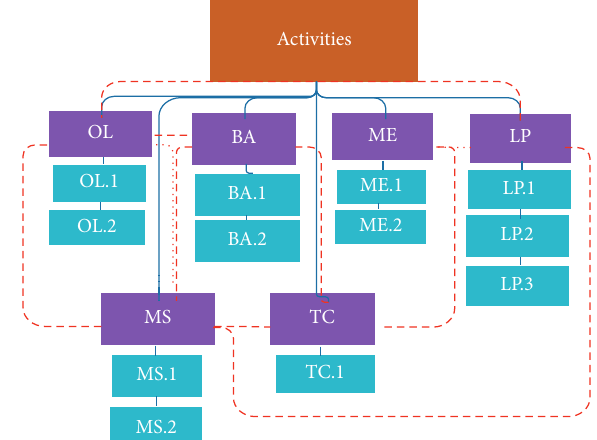
Figure 2: Fuzzy activity model: Iran’s science and technology